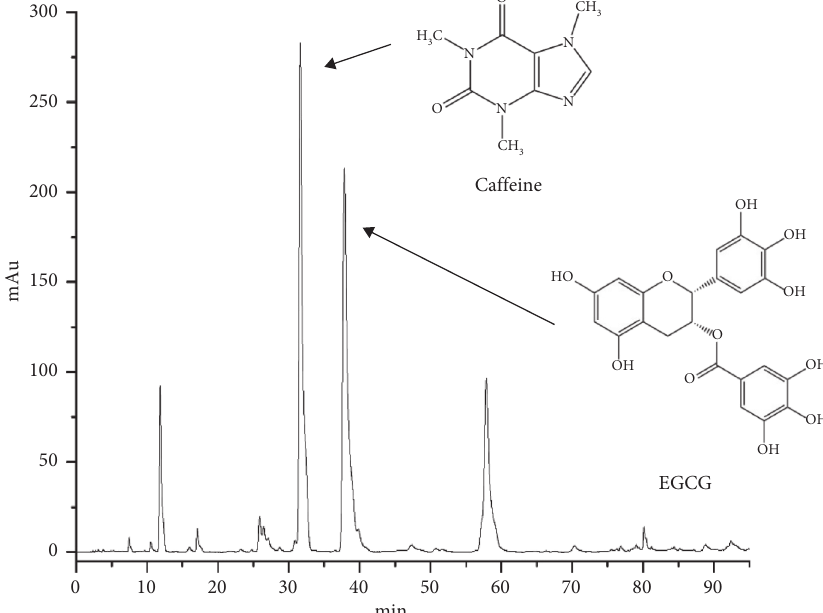
Figure 3: A typical HPLC chromatogram and the chemical structures of caffeine and